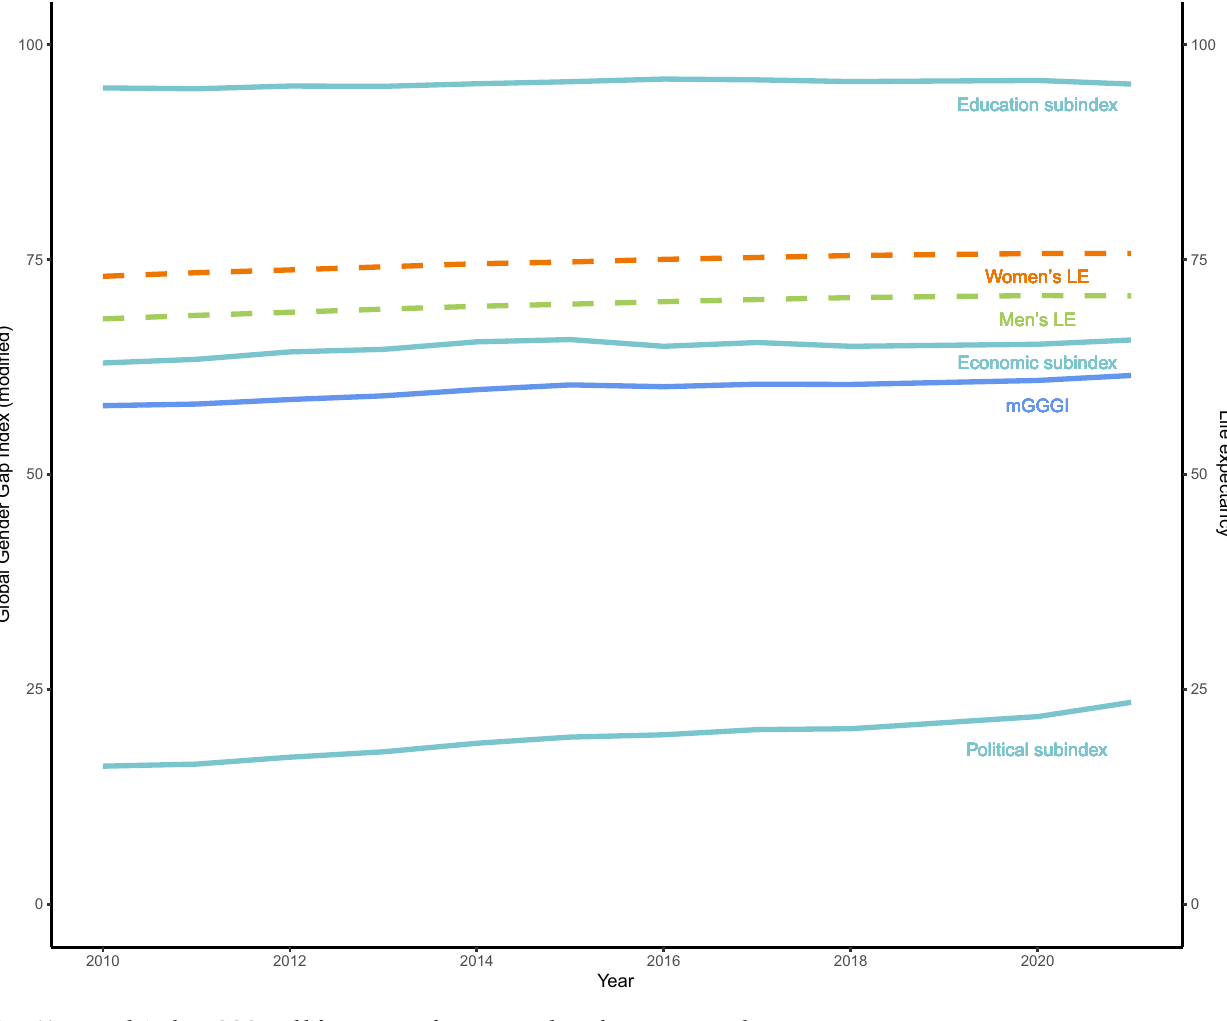
Fig 1. Time trends in the mGGGI and life expectancy for women and men between 2010 and 2021.